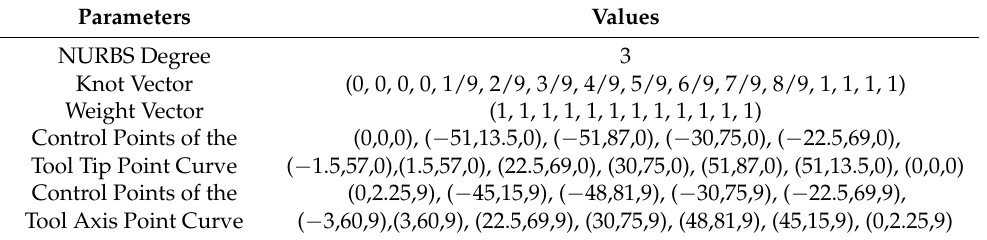
Table A2. Parameters of the Cardioid